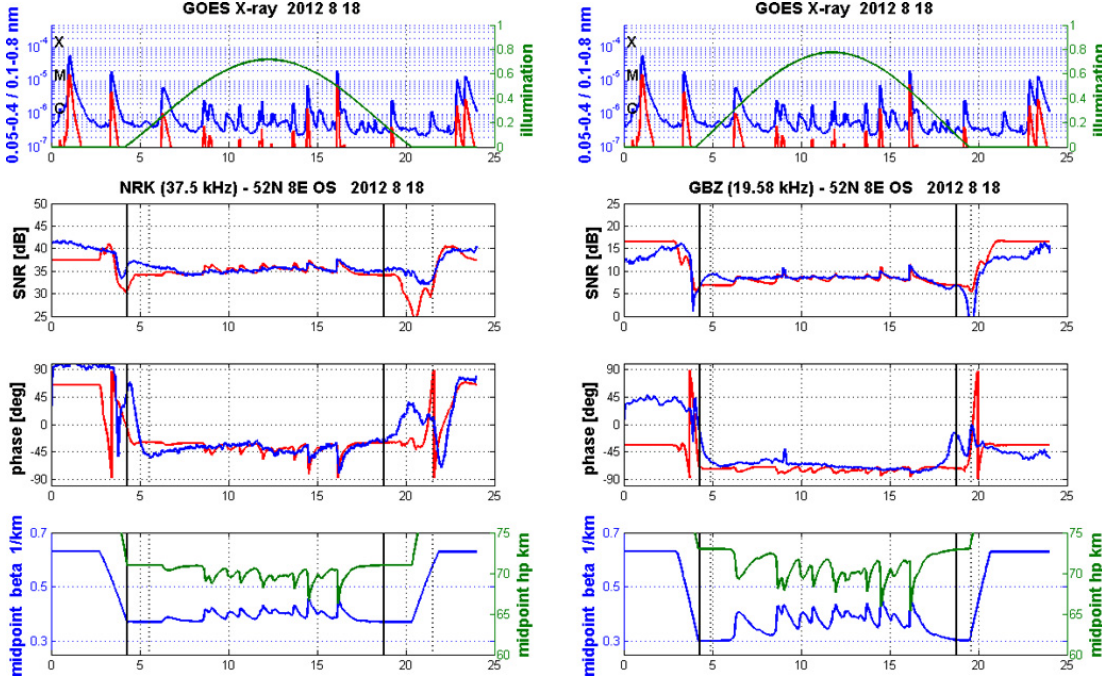
Fig. 7. On 18 August 2012; variety of C and M flares from sunspot group AR1542 near-solar limb; left panel: NRK 37.5kHz, h m = 74km, = 71km, β = 0 . 37km − 1 ; right panel: GBZ 19.58kHz, h m = 72km, h 0 h 0 d d phase) blue and red are the recorded and calculated values, respectively.